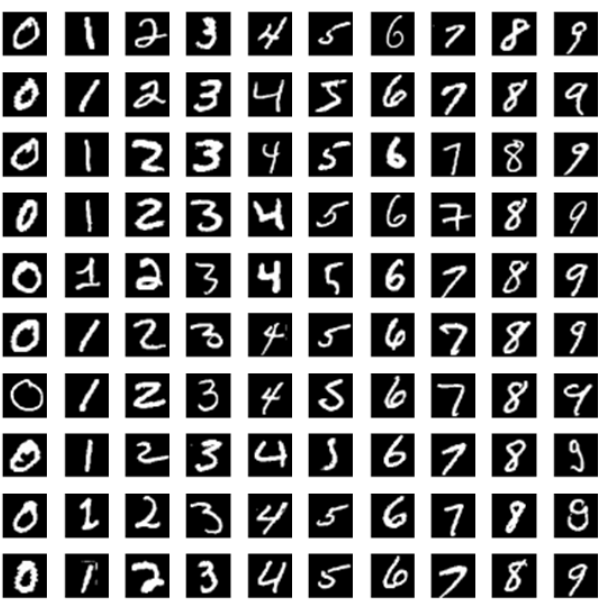
Figure 6. Some handwritten